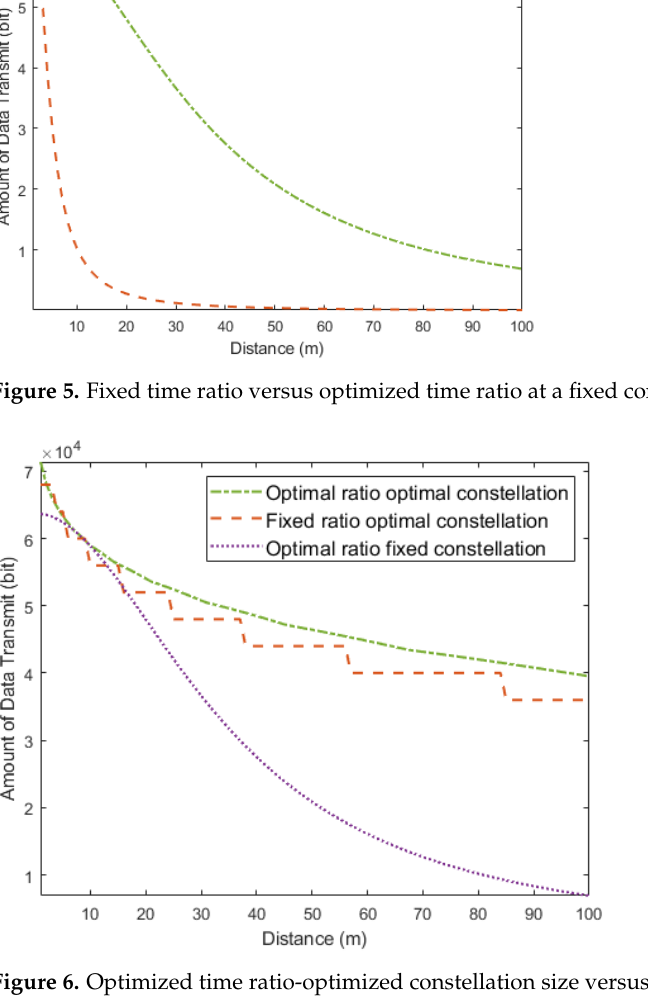
Figure 6. Optimized time ratio-optimized constellation size versus single optimized factor.